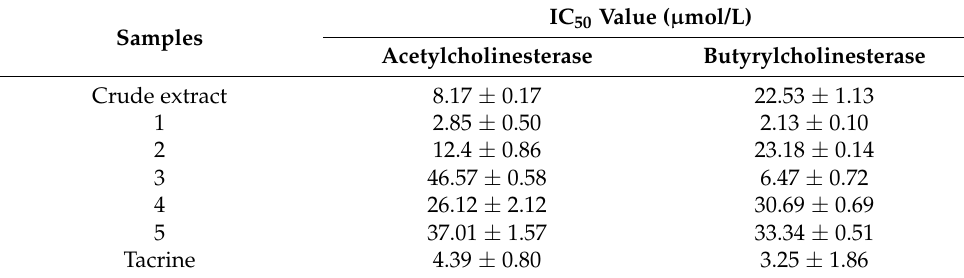
Table 2. Cholinesterase activity of compound 1 – 5